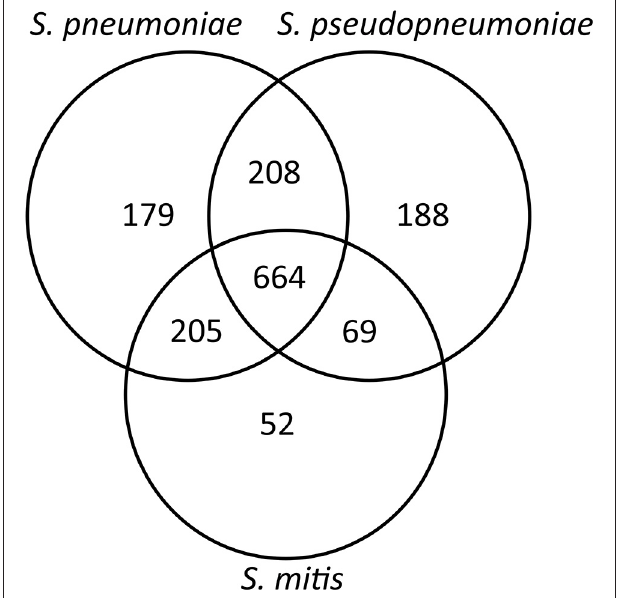
FIGURE 2 | Venn diagram showing the number of shared and unique genes between S. pneumoniae . S. pseudopneumoniae and S. mitis .